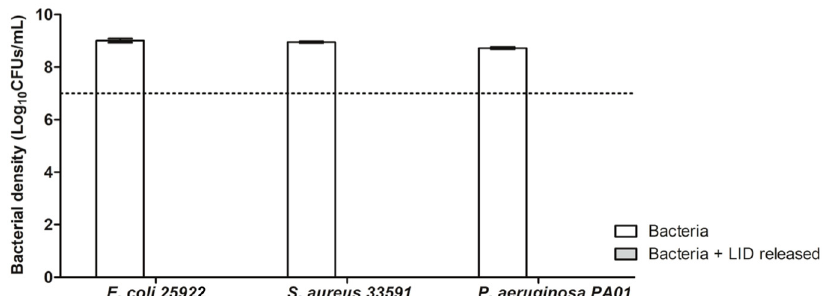
Figure 9. Antimicrobial activity of LID released from GMS-LID10 particles. Bacterial growth without LID after 24 h of incubation was used as control (white bars). Horizontal dashed line indicates the initial bacterial density. The LID released from GMS-LID10 particles was able to kill all bacteria after 24 h of culture.